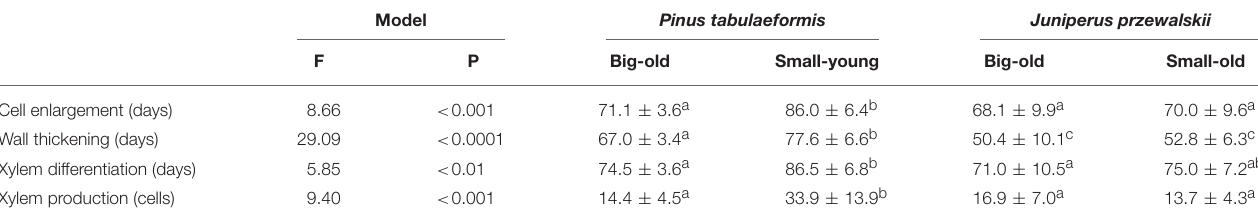
TABLE 2 | Comparisons between the duration of the differentiation phases and the xylem cell production in trees of Pinus tabulaeformis and Juniperus przewalskii . Model Pinus